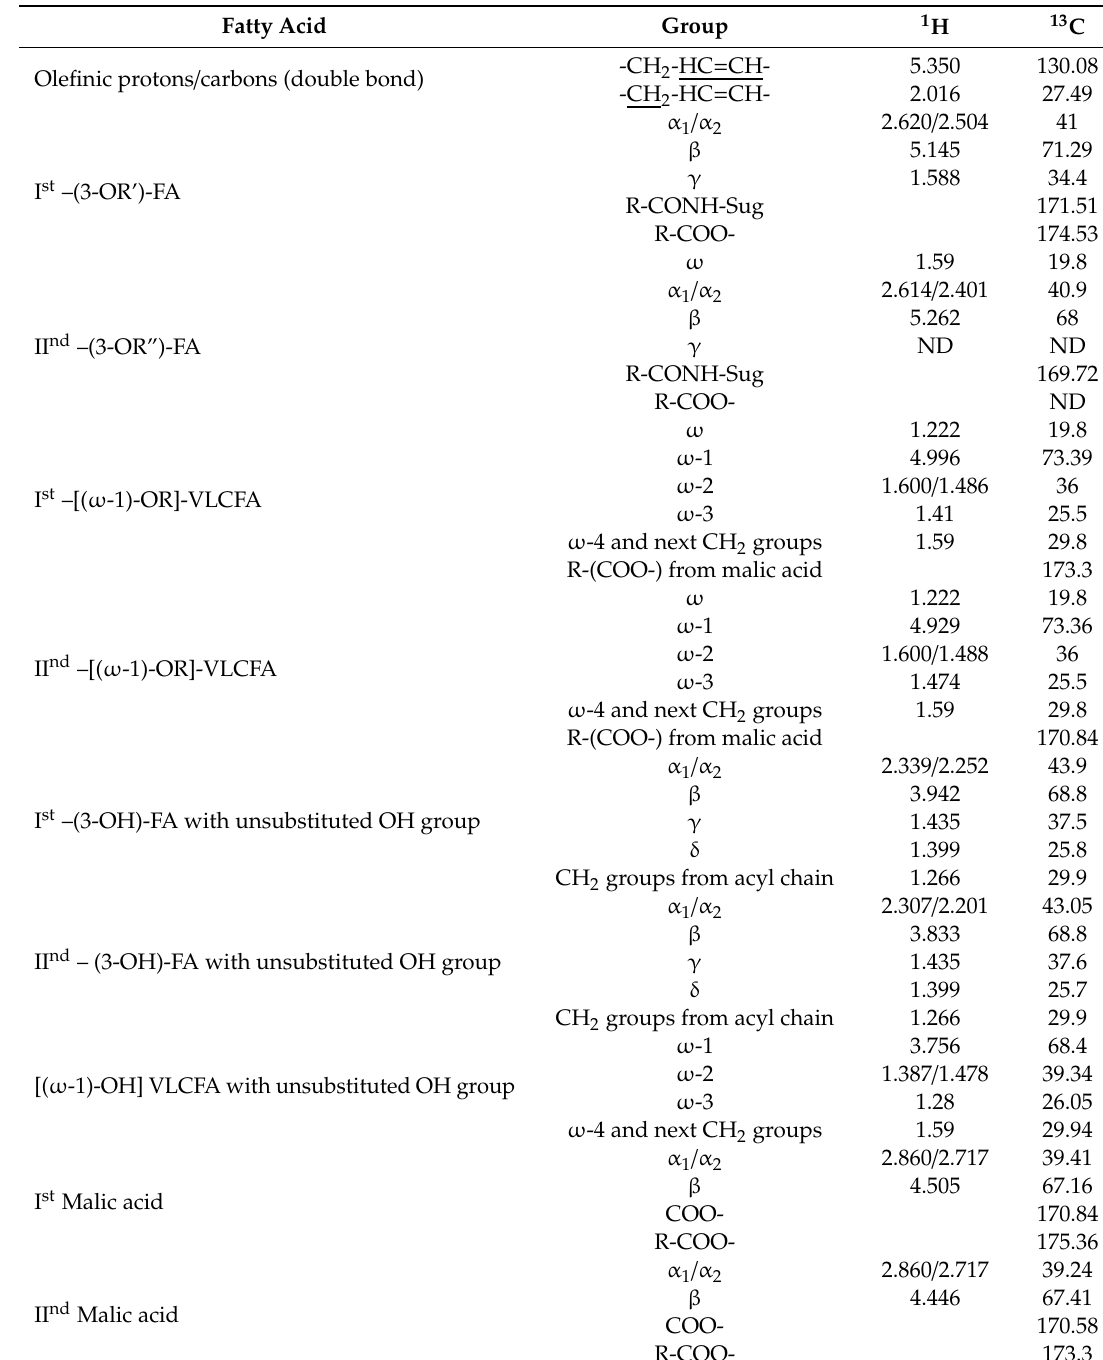
Table 3. 1 H and 13 C NMR chemical shifts [ppm] of acyl substituents of O. carboxidovorans OM5 lipid A. Underling means assigning the signal to the specific